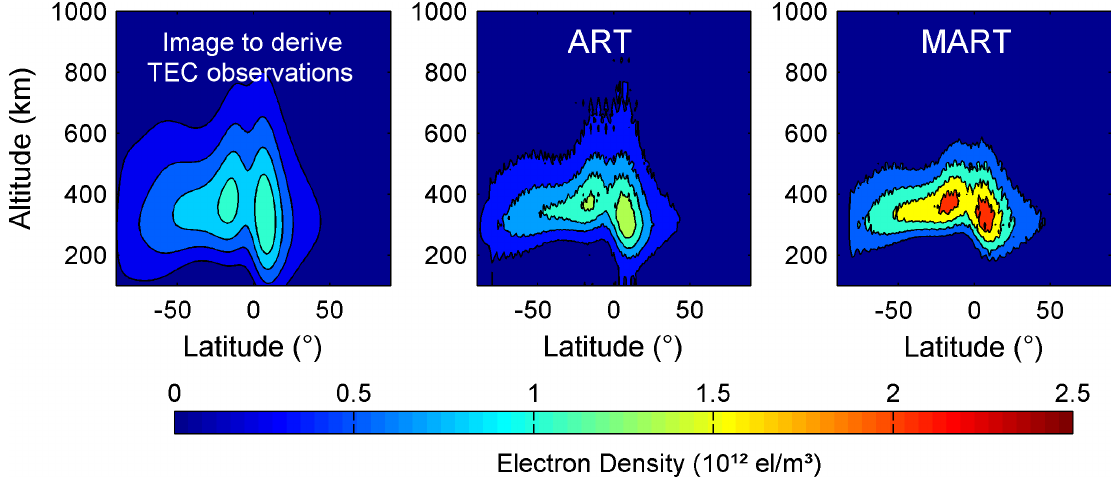
Figure 6 - 2D algebraic technique performance in Case IV (shape variation).